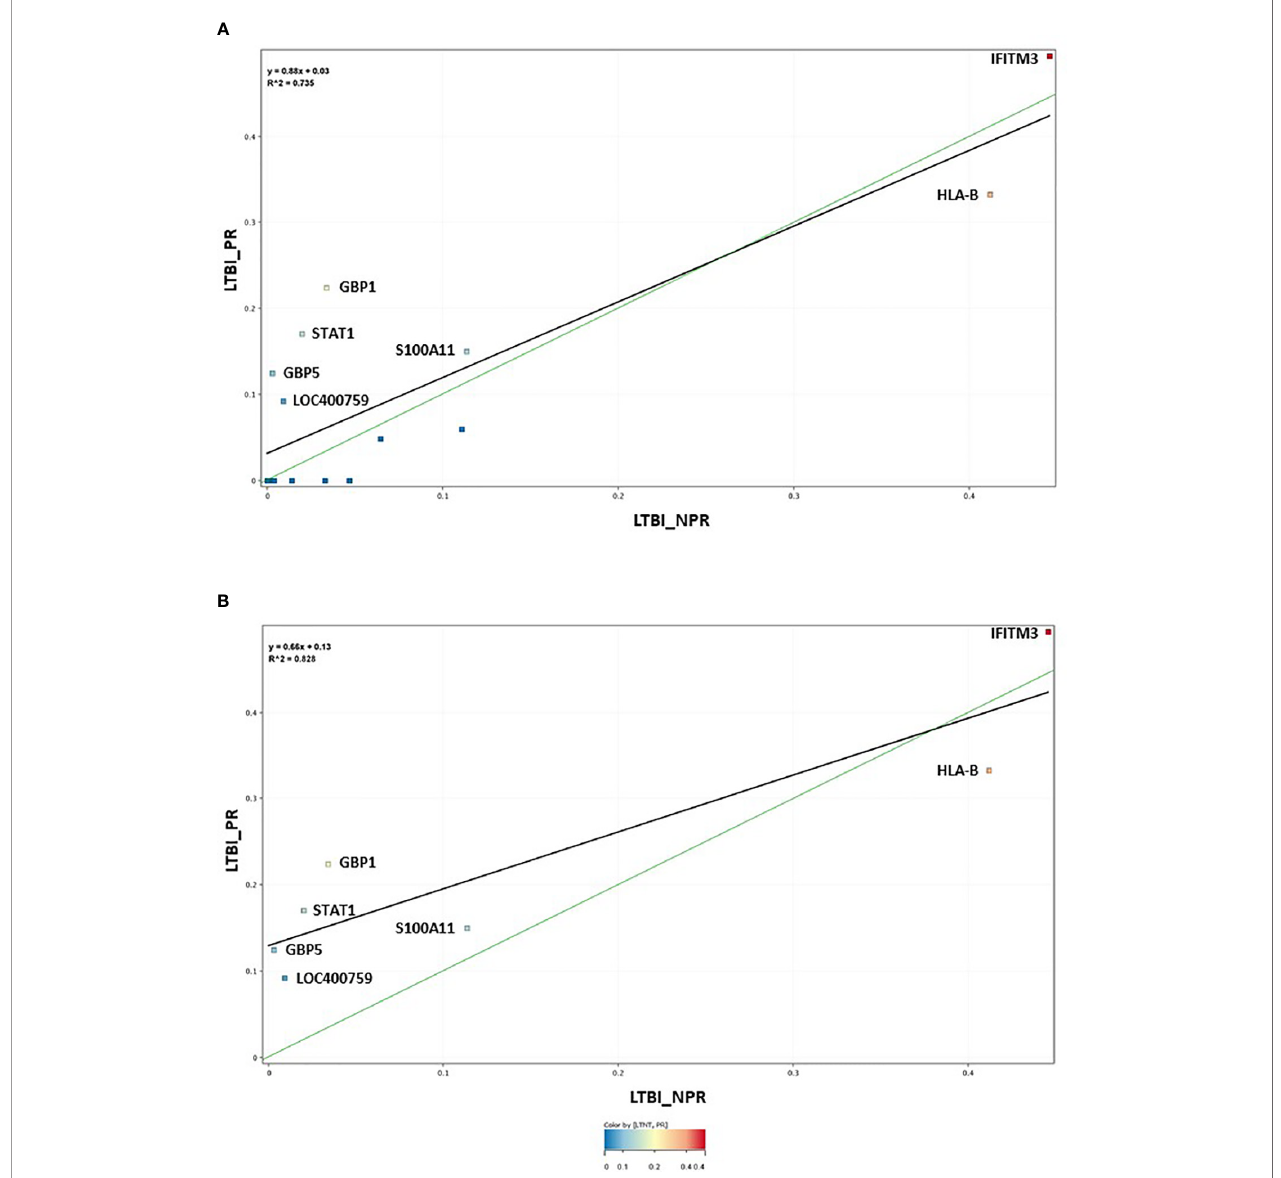
FIGURE 2 | (A) Scatter graph depiction of the seventeen statistically signi fi cant entities in LTBI non-progressor and LTBI progressor groups, with associated linear regression (R 2 ) signi fi cance analysis (B) Scatter graph depiction of the seven preferred, differentially expressed entities in LTBI non-progressor and LTBI progressor groups, with associated linear regression (R 2 ) signi fi cance